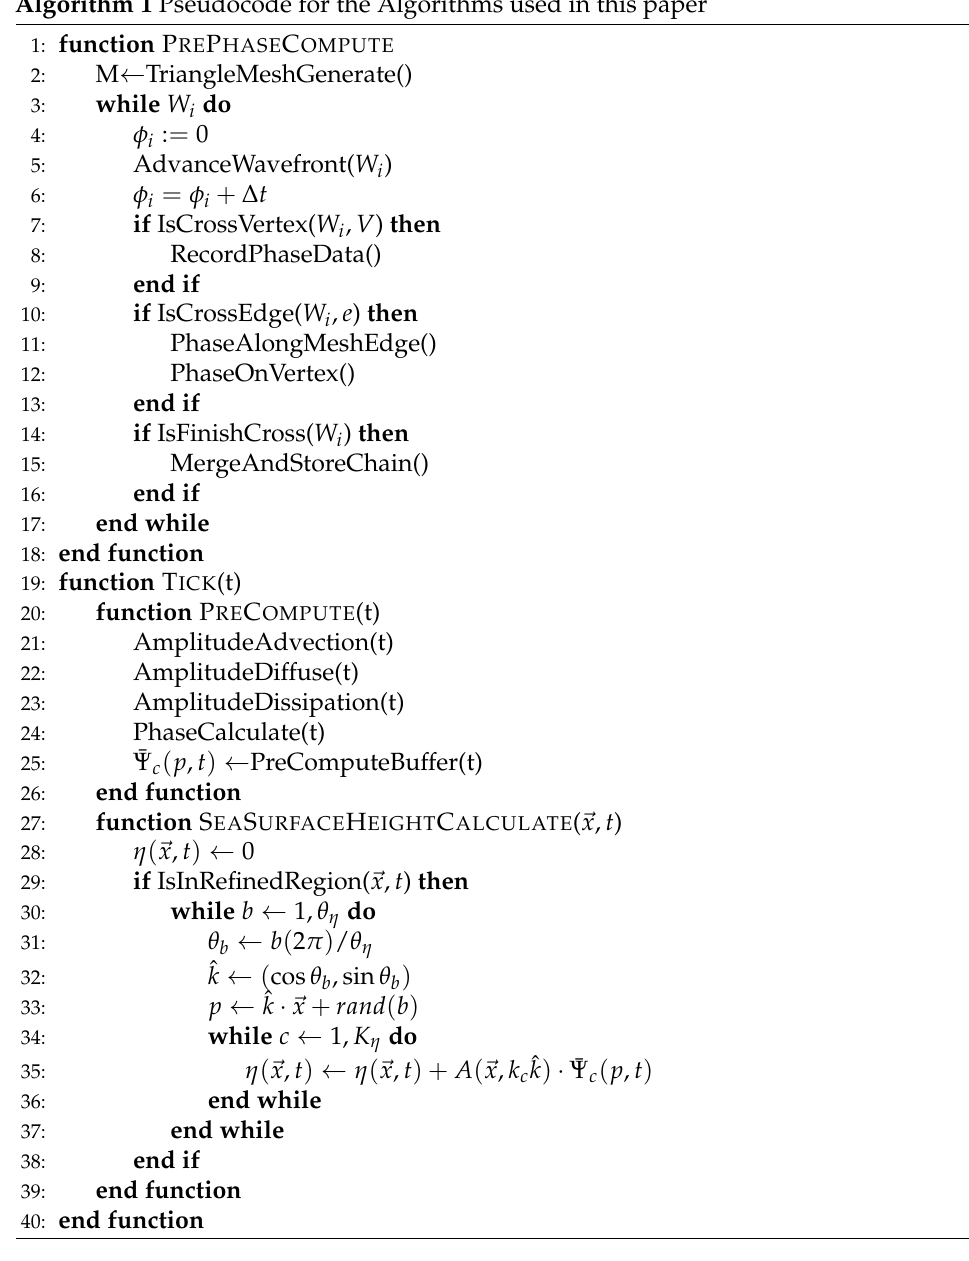
Algorithm 1 Pseudocode for the Algorithms used in this